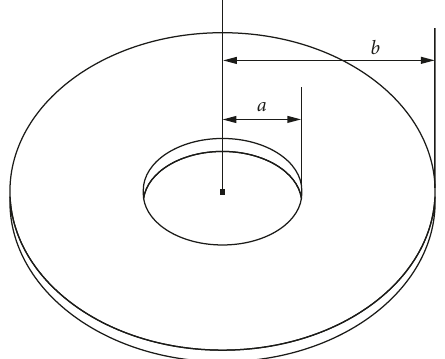
Figure 1: Schematic diagram of the